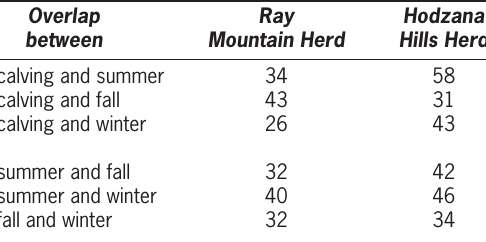
Table 4. Percent overlap in seasonal ranges (constructed using 90% cumulative probability contour based on kernel density smoothing) of Ray Mountain and Hodzana Hills caribou